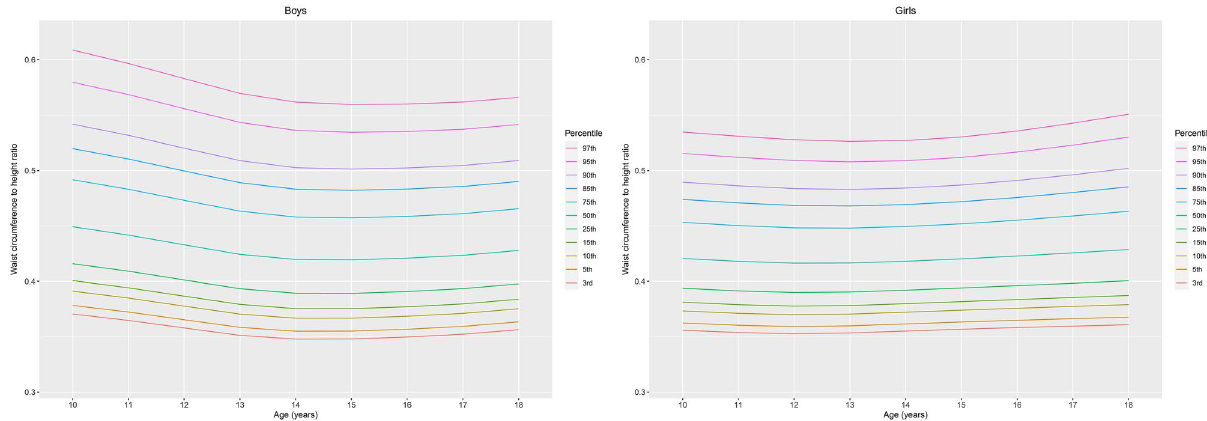
Figure 1. Percentile curves of the age- and sex-specific waist-to-height ratio of children and adolescents aged 10–18